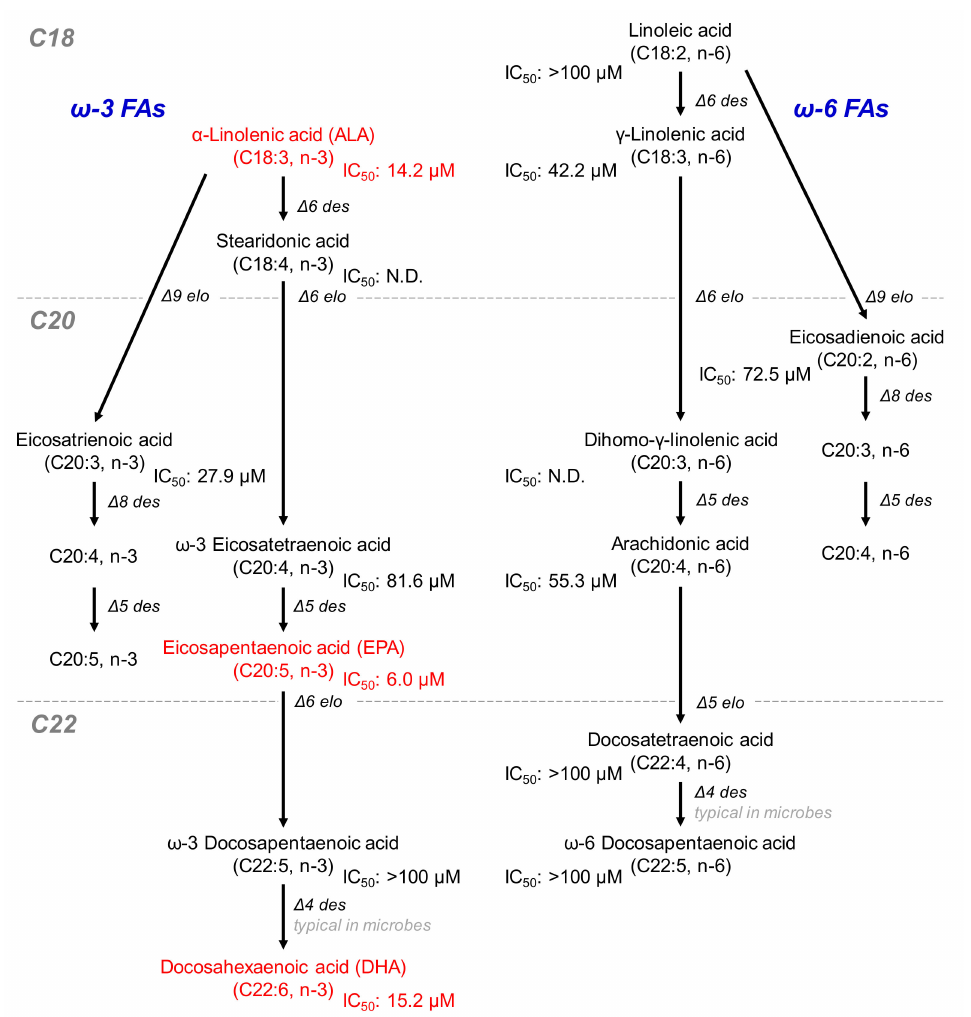
Figure A4. Biosynthetic route of fatty acids and half maximal inhibitory concentration (IC 50 ) values of each tested fatty acid against the urate transport mediated by URAT1. The IC 50 values are from Figures 2, 3 and A3. Three polyunsaturated fatty acids with substantial URAT1-inhibitory activities are indicated in red. N.D., not determined in this study; FAs, fatty acids; des , desaturase; elo , elongase. The metabolic pathway is adapted from a previous report [4], with some